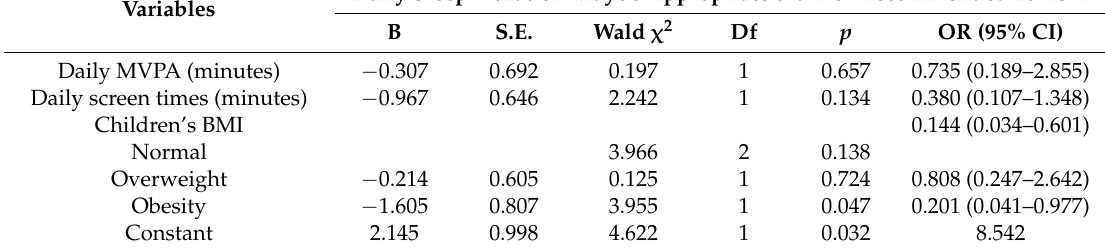
Table 4. Binary logistic regression coefficients (95% CI) for sleeping an appropriate or recommended length of time (8–13 h) ( n =